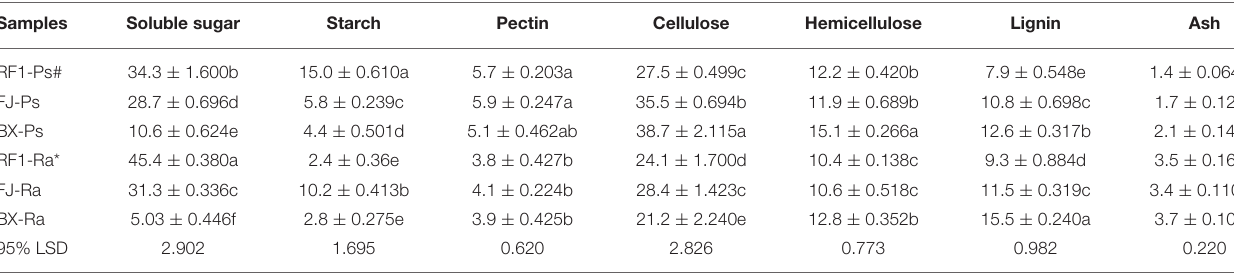
TABLE 4 | Cell wall composition (% dry matter) of pseudo-stem and rachis tissues in the RF1 and FJ samples. Samples Soluble sugar Starch Pectin Cellulose Hemicellulose Lignin Ash